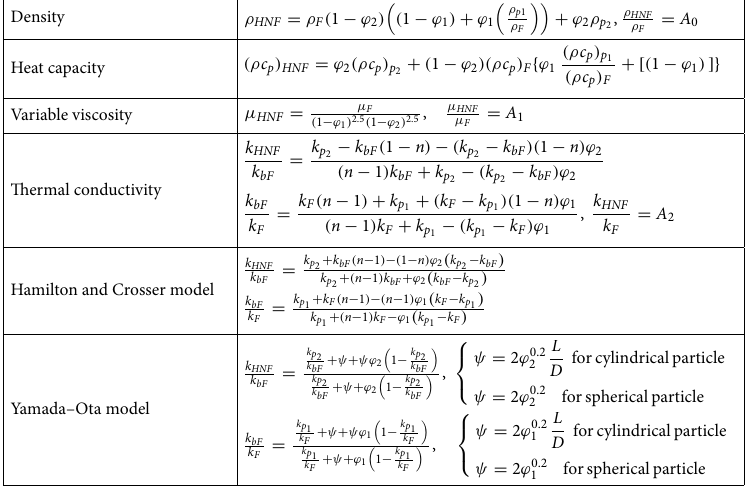
Table 3. Thermophysical properties of Hybrid nanoliquid 32